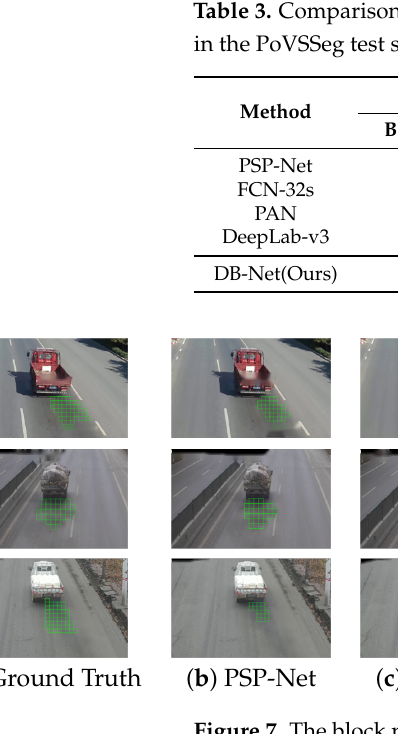
Figure 7. The block prediction result for vehicle